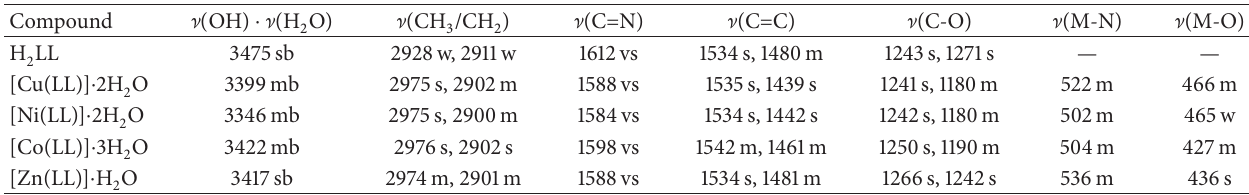
LL ] and its metal complexes. 2